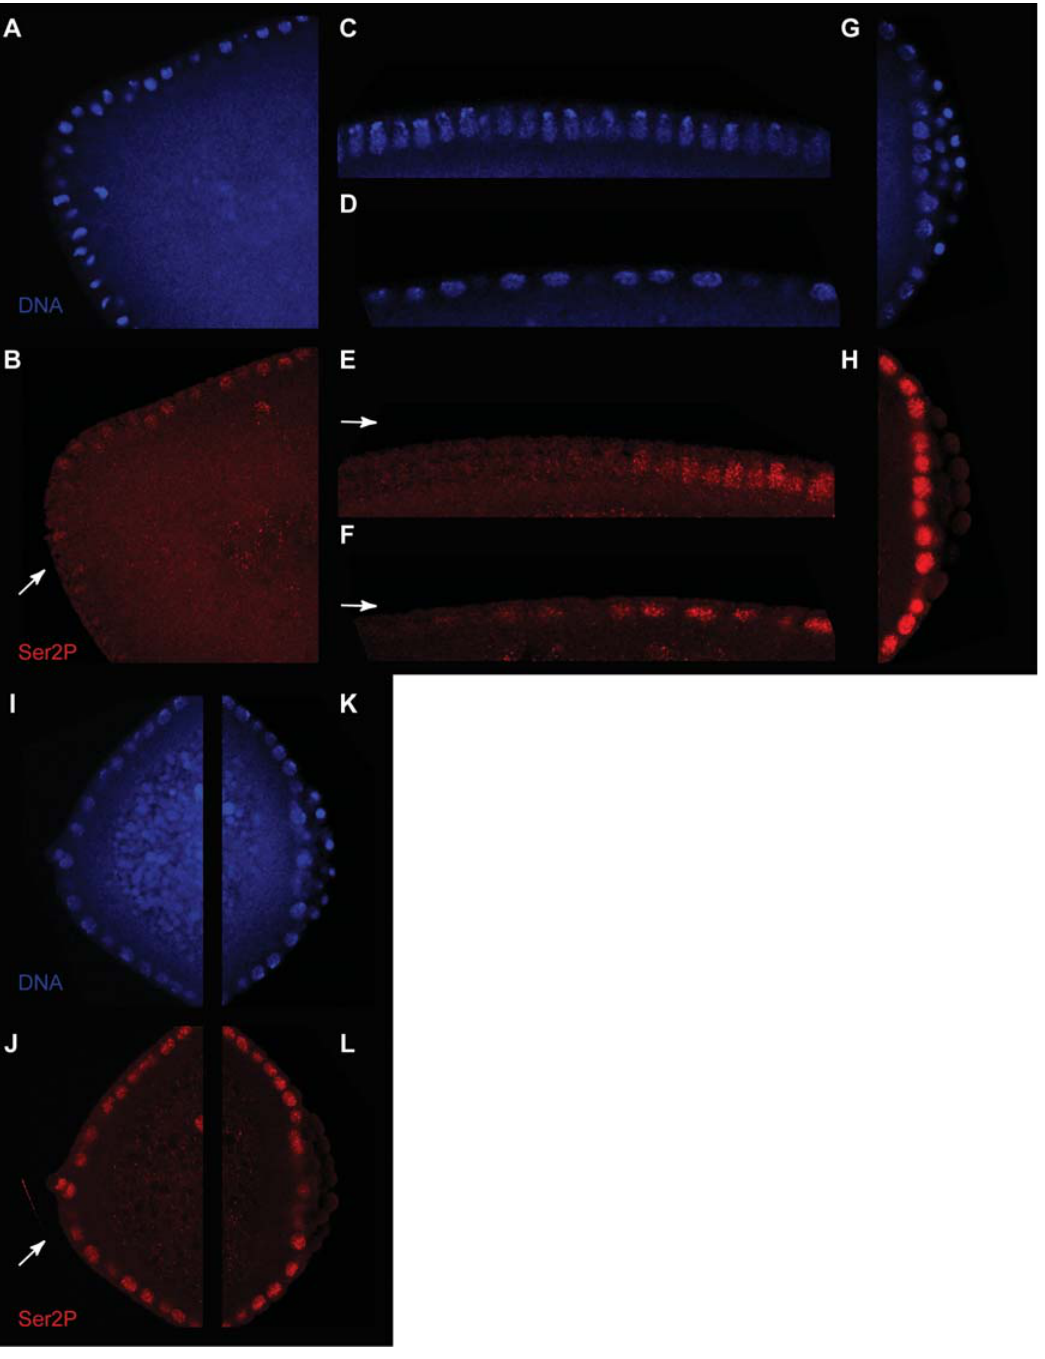
Figure 3. Microinjection of recombinant Pgc protein strongly reduces CTD Ser2 phosphorylation in Drosophila embryonic nuclei. Pgc was injected (arrows) into the anterior region of stage 3–4 Drosophila embryos. Representative images of embryos fixed 30 minutes after the injection of Pgc protein ( A – H ) or buffer only ( I – L ). DNA detected by Hoechst stain (purple, A , C , D , G , I , K ) and CTD phospho-Ser2 (green, B , E , F , H , J , L ). Ser2 phosphorylation strongly decreases at the site of injection (arrow, B ). In comparison, somatic cell nuclei in the posterior area of the same embryo show no changes in Ser2 phosphorylation ( H ). Ser2 phosphorylation is gradually lost when moving away from the site of injection ( E , F , arrow, left, denotes anterior region). Ser2 phosphorylation does not decrease with control injections ( J ) when compared to the uninjected area ( L ).